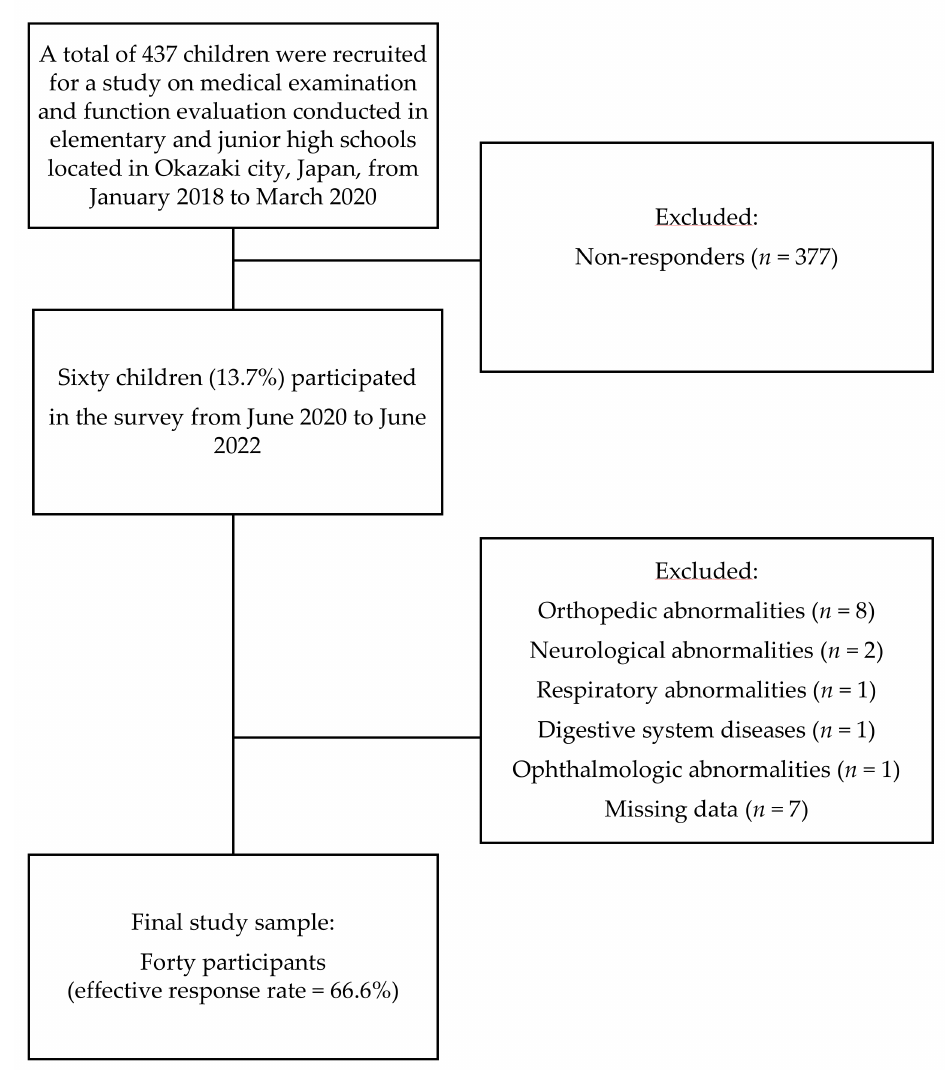
Figure 1. Flowchart of this prospective longitudinal observational